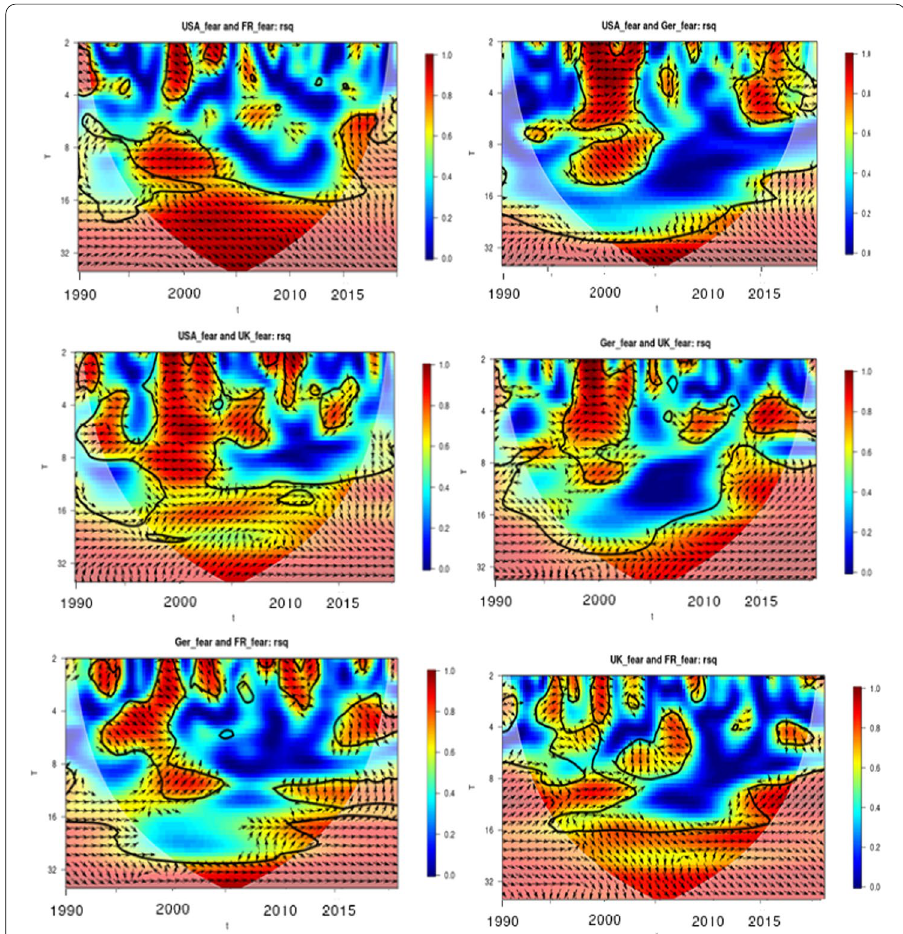
Fig. 4 The squared wavelet coherency and phase difference between different migration Fear indices in European refugees pre and crisis periods. Figure display the squared wavelet coherence of two series. The thick blue contour represents the 5 per cent significance level. The cone of influence, which indicates the region affected by edge effects, is shown with a lighter shade black line. The color code for power ranges from blue (low power) to red (high power). The phase difference between the two series is indicated by arrows. Arrows pointing to the right mean that the variables are in phase. To the right and down, the first series is leading the second series with positive correlation. To the right and up, the second series is leading the first series with positive correlation. Arrows pointing to the left mean that the variables are out of phase. To the left and up, first series is leading the second series with negative correlation. To the left and down, the second series is leading the first series with negative correlation. In-phase indicates that the variables have cyclical effect on each other and out of phase or anti-phase shows that the variables have anticyclical effect on each other. The cone of influence where edge effects should be considered is shown as a lighter shade. The darker red (areas with arrows) regions are the higher degree of co-movement. These areas represent the spaces with high dependence, where R-squared is close to 1. The blue areas are signaling a low dependence meaning a low co-movement. The color scale represents the magnitude of